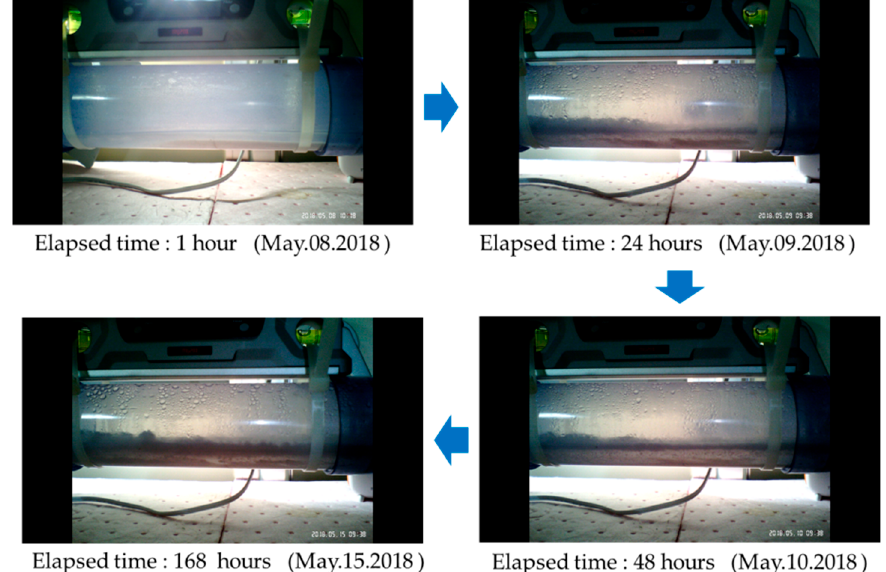
Figure 3. Deposition process of solids in the sewer pipe in the simulated experiment (Observation point 4).